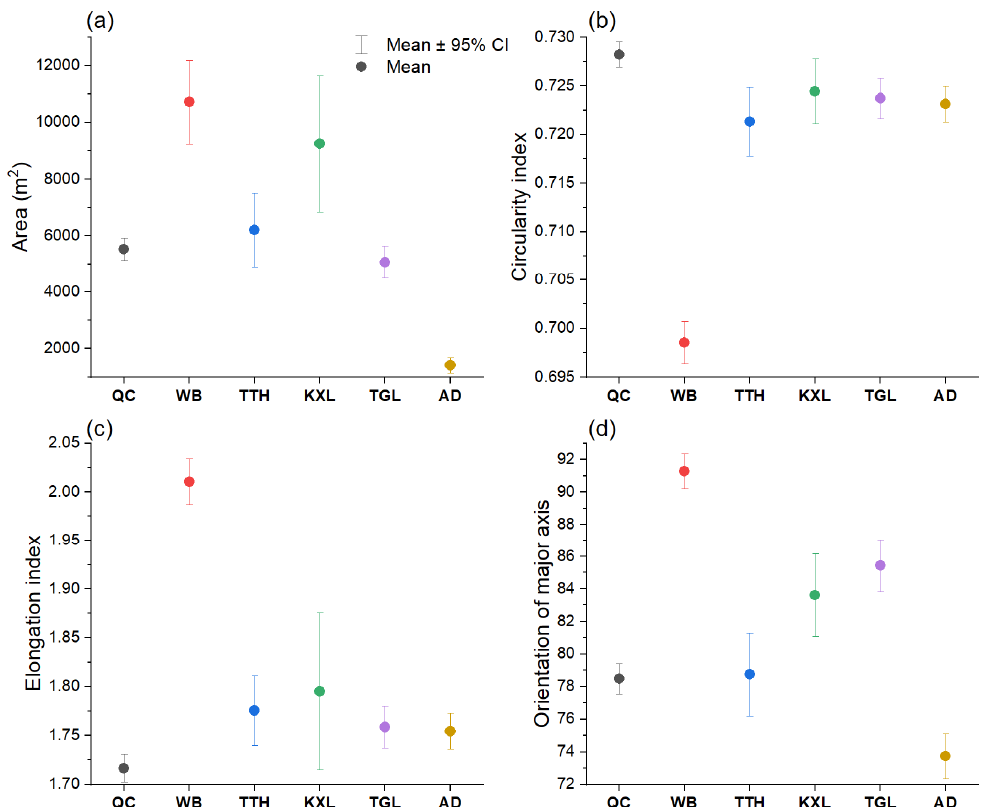
Figure 5. The morphometric characteristics of TLs in six subregions. QC= Qinghusihe–Chumaerhe; WB = Wudaoliang–Beiluhe; TTH = TuoTuohe; KXL = Kaixinling; TGL = Tanggula; AD = Anduo. ( a ) area distribution; ( b ) circularity index (EI); ( c ) elongation index (EI); ( d ) major axis orientation of TLs. 0° = east, 90° = north, 180° = west.